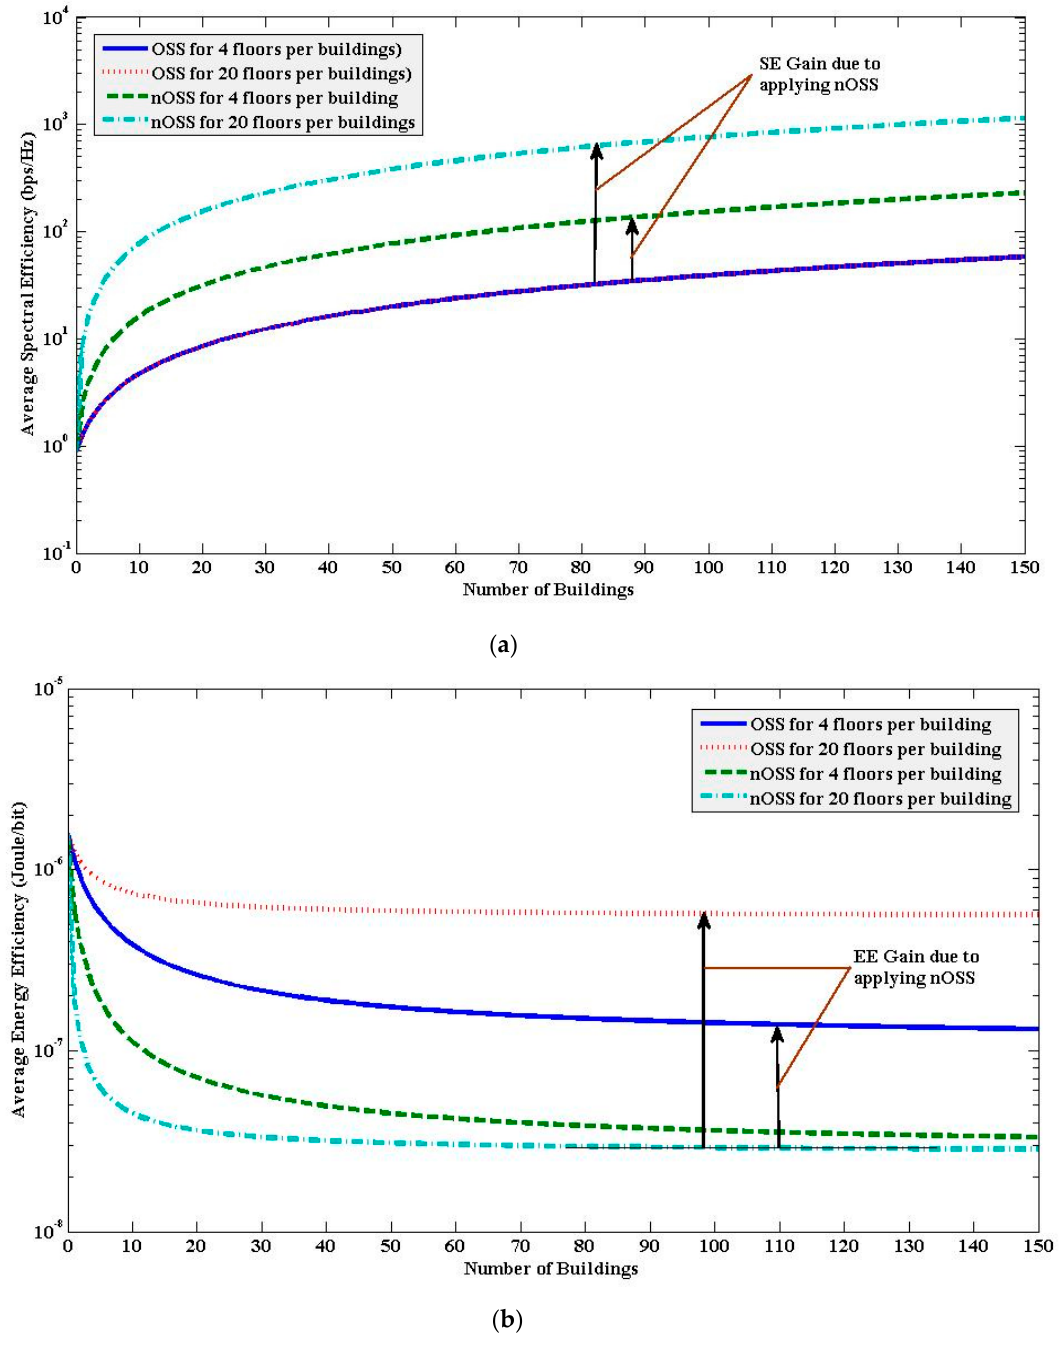
Figure 5. Spectral efficiency and energy efficiency responses of OSS and nOSS of aTMS for the variation of L . ( a ) Average spectral efficiency versus L ; ( b ) Average energy efficiency versus L .